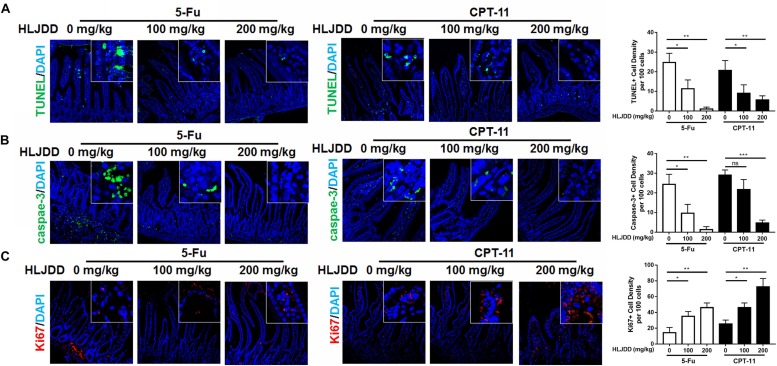
Pre-treatment of HLJDD reduced intestinal cell apoptosis and improved renewal in chemotherapy-treated mice. (A) Showed that pre-treatment of HLJDD could significantly reduce the positive TUNEL signal in the intestinal section of chemotherapy-treated mice; (B) showed that pre-treatment of HLJDD could significantly reduce the expression of cleaved caspases-3 in the intestinal section of chemotherapy-treated mice; (C) showed that pre-treatment of HLJDD could significantly improve the renewal-associated Ki67 expression in the intestinal section of chemotherapy-treated mice. *p < 0.05, **p < 0.01, ***p < 0.001 when compared with the model group.